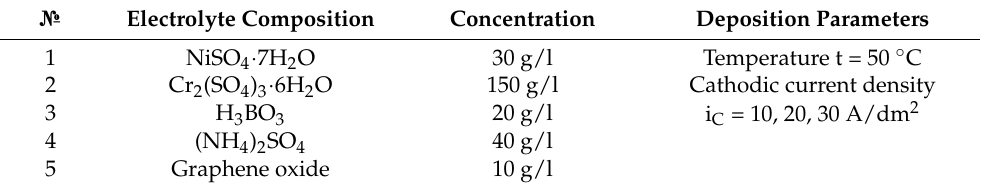
Table 1. Electrolyte bath composition and deposition parameters used for nickel–chromium–GO composite